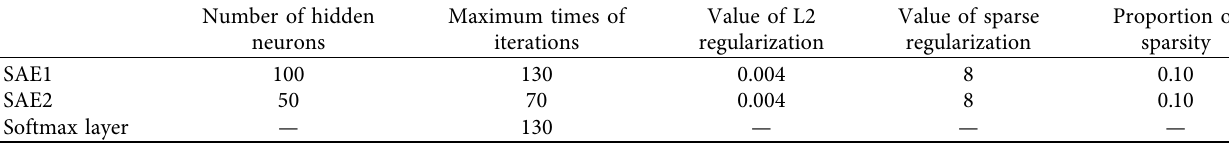
Table 1: Parameter values of the algorithm in this article.